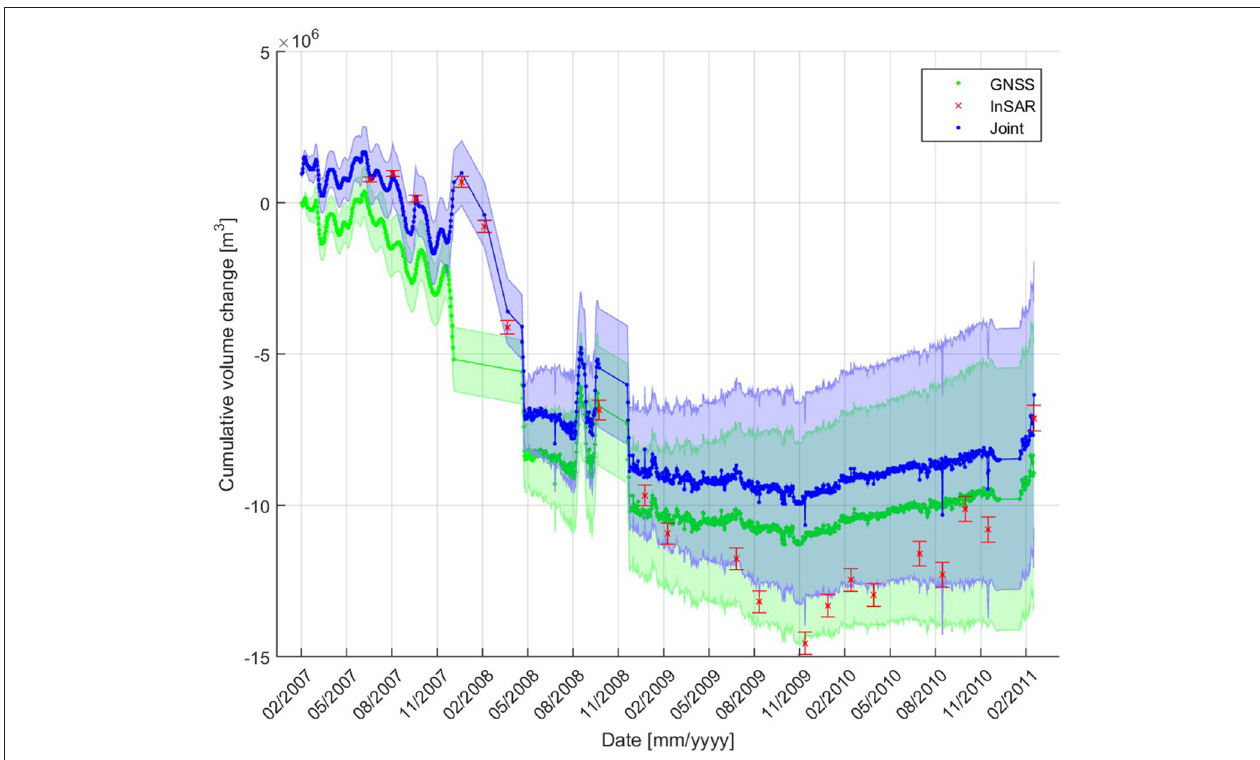
FIGURE 7 | Time series inversion of the best source location determined from the joint inversion grid search. Cumulative volume change is plotted based on three inversions constrained by GNSS data only, InSAR data only and the joint inversion of GNSS and InSAR data. Uncertainties (1-sigma) are plotted as shaded error envelopes for the GNSS and joint inversions, and as error bars for the InSAR